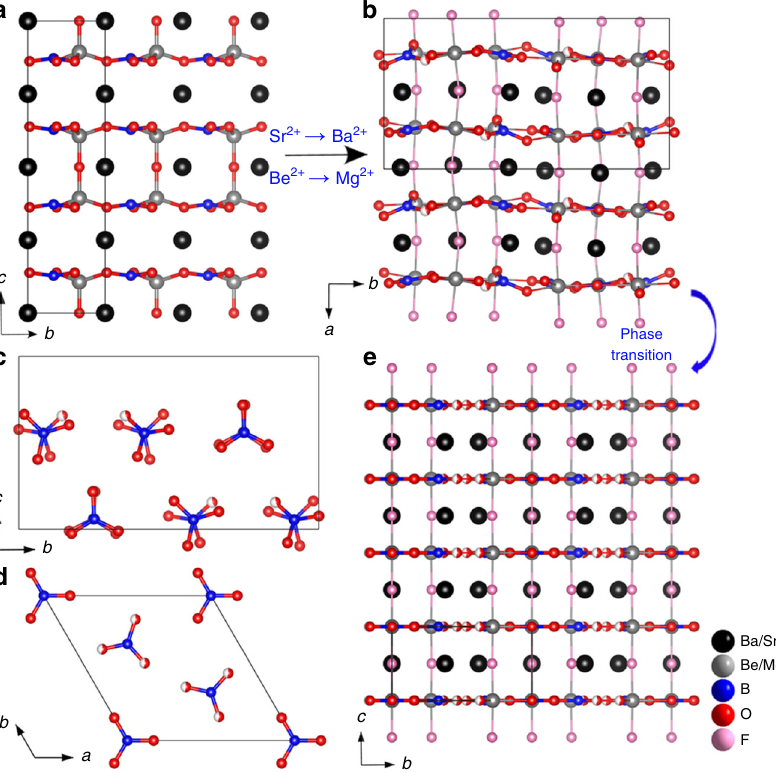
Fig. 2 Crystal structural features of Pna 2 1 -Ba 3 Mg 3 (BO 3 ) 3 F 3 . a , b The structural evolution from Sr 2 Be 2 B 2 O 7 to Pna 2 1 -Ba 3 Mg 3 (BO 3 ) 3 F 3 . c , d The orientation of [BO 3 ] 3 − groups in Pna 2 1 - and P (cid:1) 62 m- Ba 3 Mg 3 (BO 3 ) 3 F 3 , respectively. e The layered structure of derivative P (cid:1) 62 m- Ba 3 Mg 3 (BO 3 ) 3 F 3 derived by phase transition from Pna 2 1 -Ba 3 Mg 3 (BO 3 ) 3 F